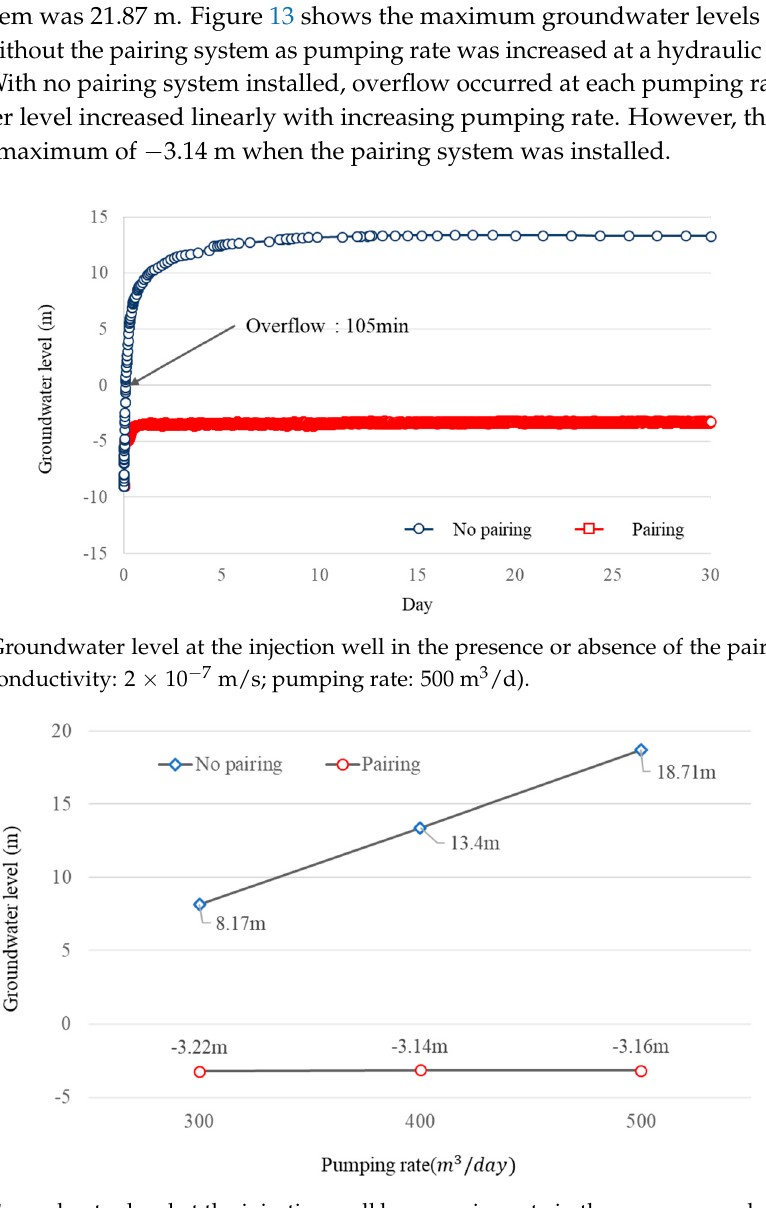
Figure 13. Groundwater level at the injection well by pumping rate in the presence or absence of the × 10 − 7 pairing system (hydraulic conductivity: 2 × 10 − 7 m/s). pairing system (hydraulic conductivity: 2